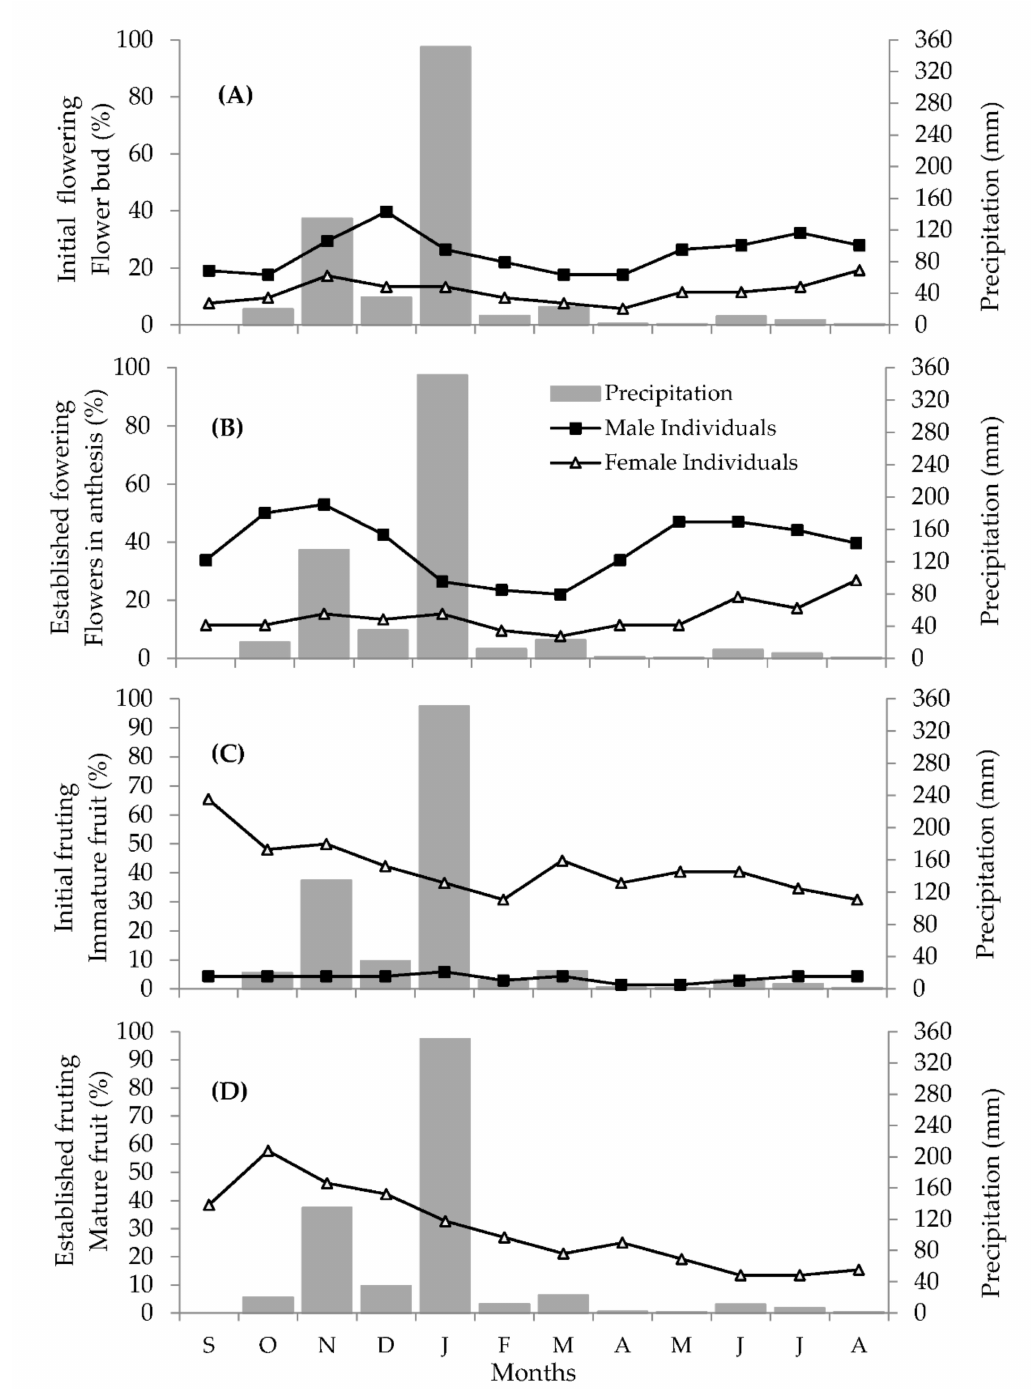
Figure 2. Fournier intensity of the reproductive phenology of male and female plants of D. sericea and accumulated precipitation (mm). Data recorded between September 2015 and August 2016. ( A ) Initial flowering intensity (flower bud); ( B ) established flowering intensity (flowers in anthesis); ( C ) initial fruiting intensity (immature fruits); ( D ) established fruiting intensity (mature